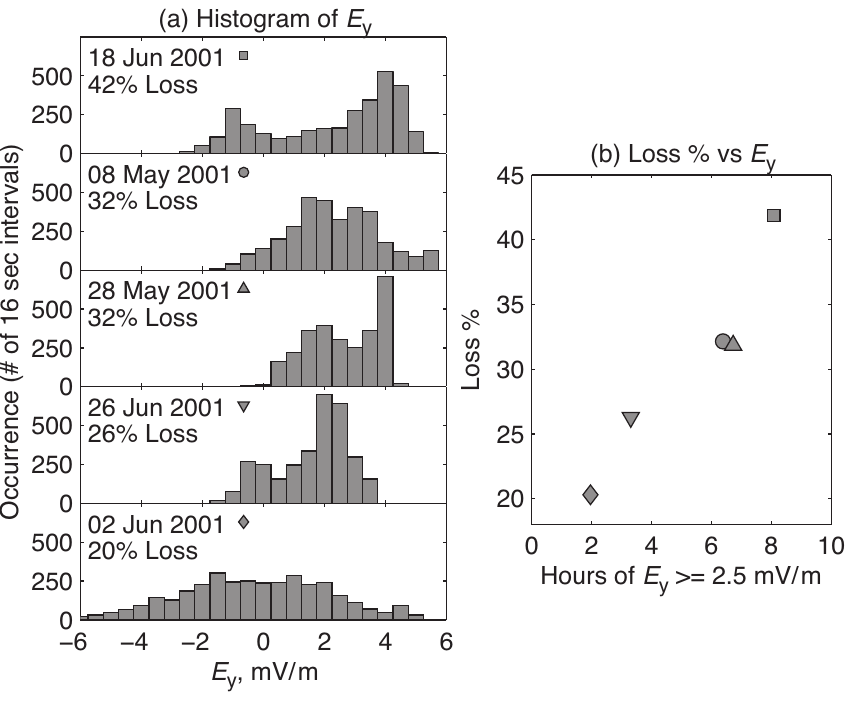
Fig. 4. (a) A histogram of the solar wind E y during each of the disturbance intervals. (b) The relationship between the percentage of He + lost during the event and the number of hours of E y ≥ 2.5.